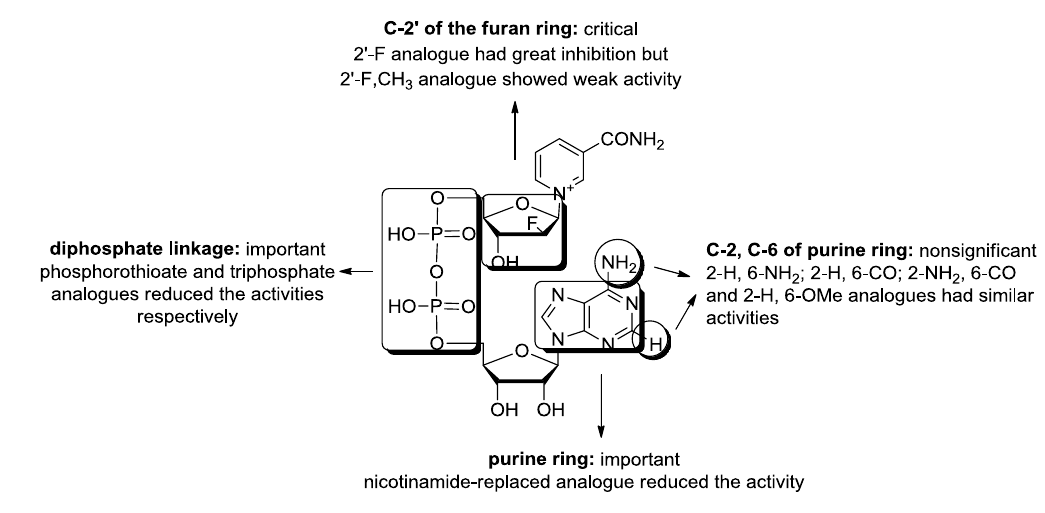
Figure 3. Preliminary structure-activity relationship for NAD